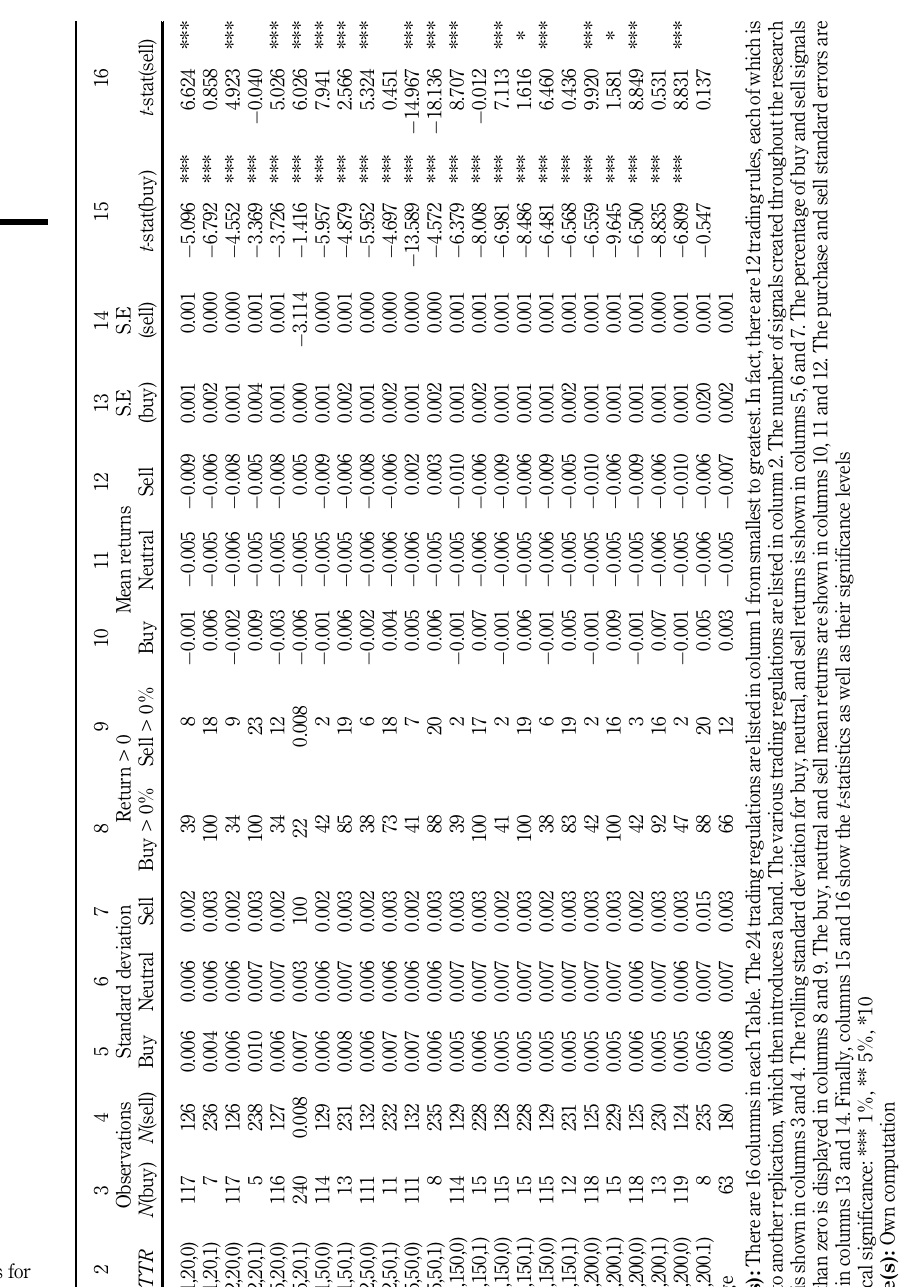
Table 3. BTC/EUR results for BBL ’ s mean difference